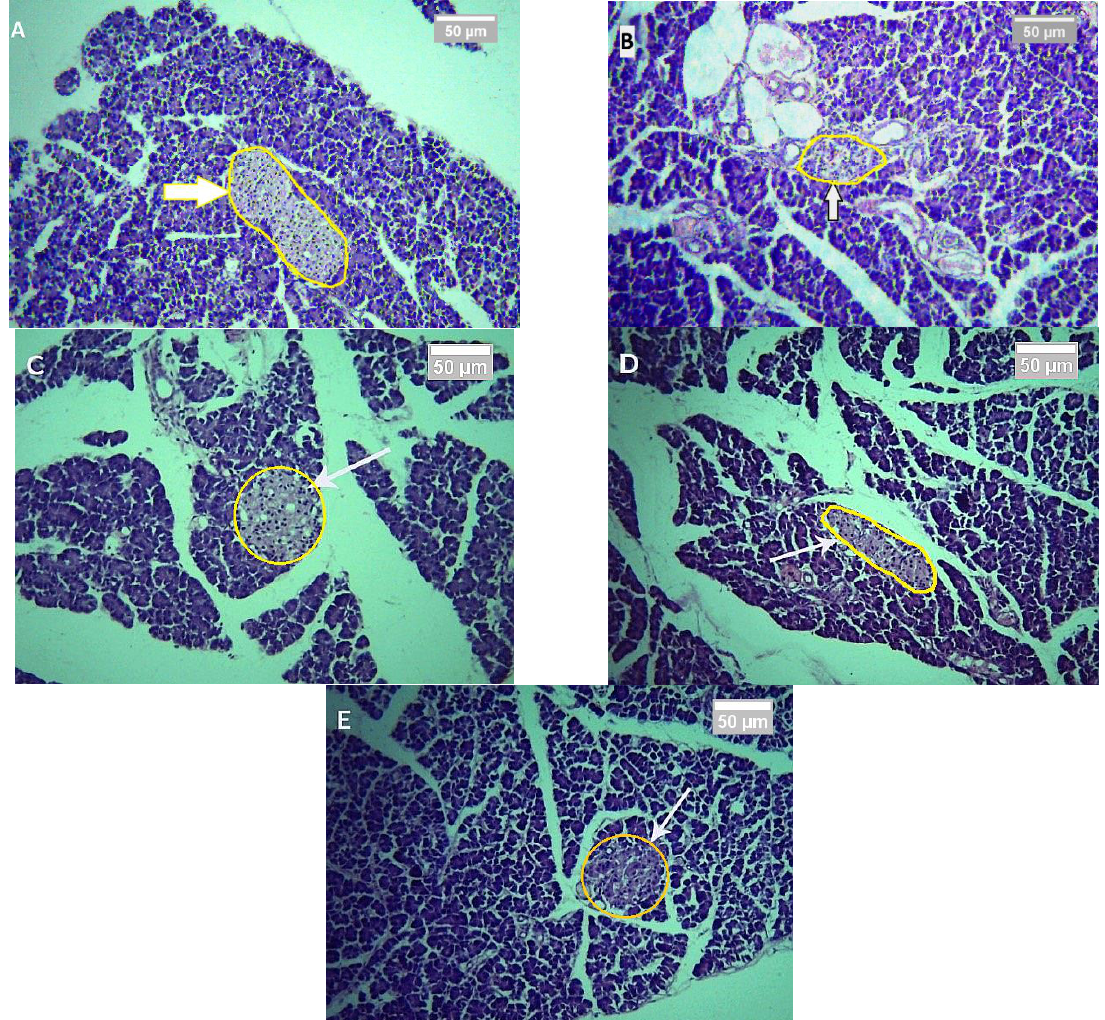
Figure 4. Histopathological slides of rat pancreas cells after 7 days of treatment: ( A ) normal control (presence of normal islet cells), ( B ) diabetic control (shrinkage of the islet cells), ( C ) diabetic + glibenclamide 150 mg/kg (increased number and size of islet cells), ( D ) diabetic + CILE × 250 mg/kg (improved size and shape of islet cells), and ( E ) diabetic + CILE × 500 mg/kg (restored number and size of islets).